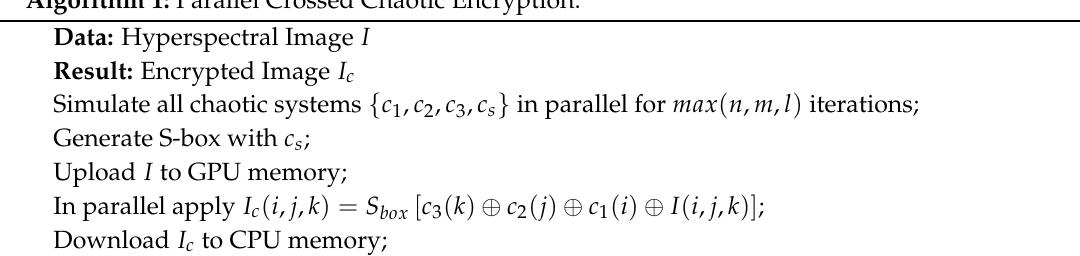
Algorithm 1: Parallel Crossed Chaotic Encryption.